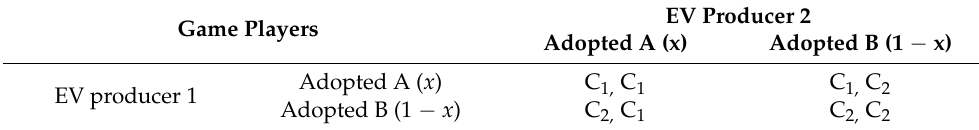
Table 2. Pay-off table of EV